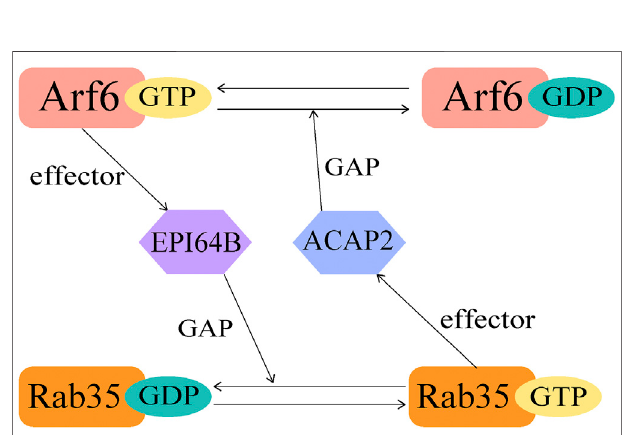
FIGURE 3 | A diagram showing the crosstalk between Rab35 and